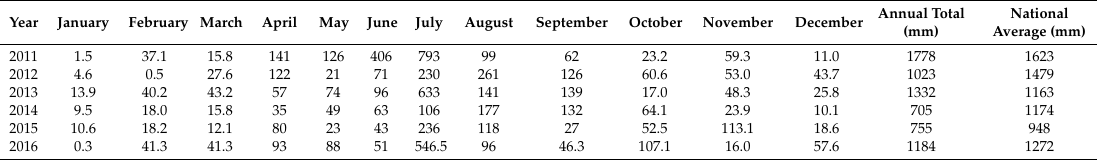
Table 2. Monthly rainfall depth at the Inje weather station.